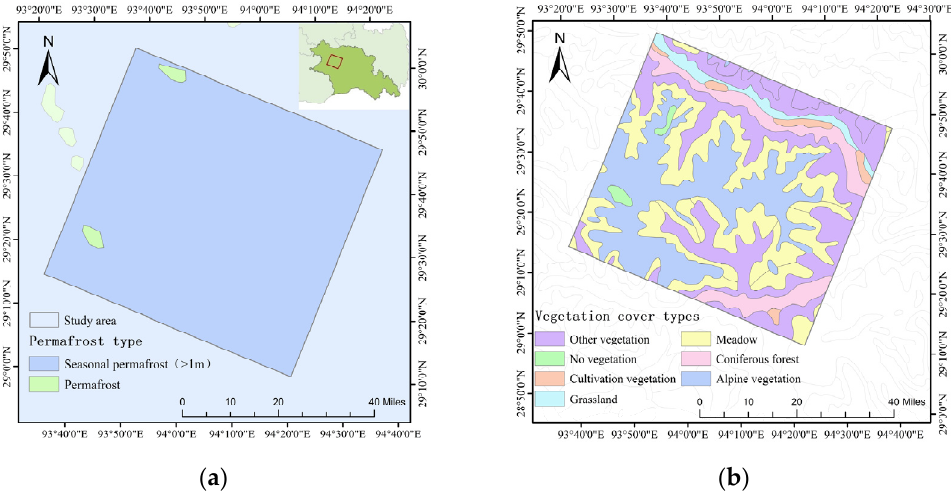
Figure 1. ( a ) Location and the distribution of permafrost in the study area; ( b ) Distribution of vege- tation types in the study